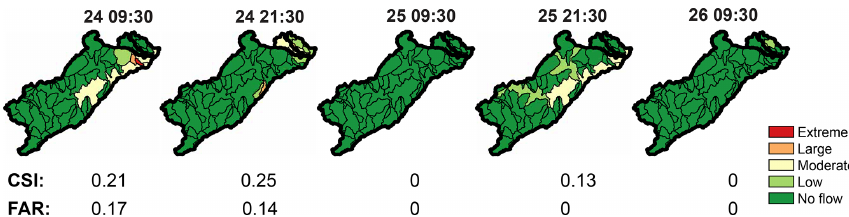
Figure 10. Flash-flood return period categories, CSI, and FAR calculated using different COSMO forecast runs from the days preceding the 26 April flash flood. Headers state the time of forecast